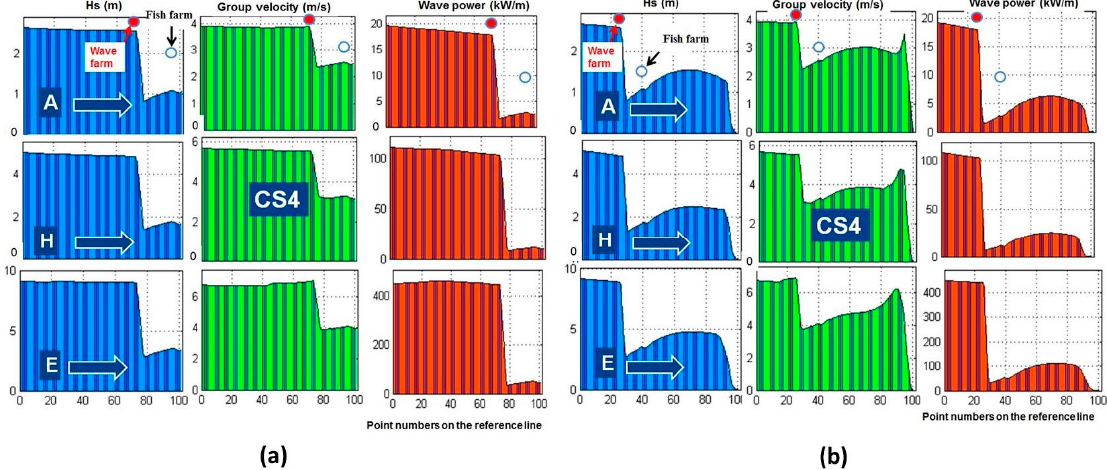
Figure 11. CS4 (multi-line scenario for the wave farm), results of the SWAN model simulations along the reference lines (RL1 and RL2). The wave parameters represented are: significant wave height, group velocity, and wave power. The reference lines are divided into 100 points equally spaced. ( a ) Model results along RL1; ( b ) model results along RL2. A—average wave conditions, H—high wave conditions, E—extreme wave conditions. The locations of the wave and fish farms are indicated in Figures 6, 8 and 10 with red and white circles, respectively.